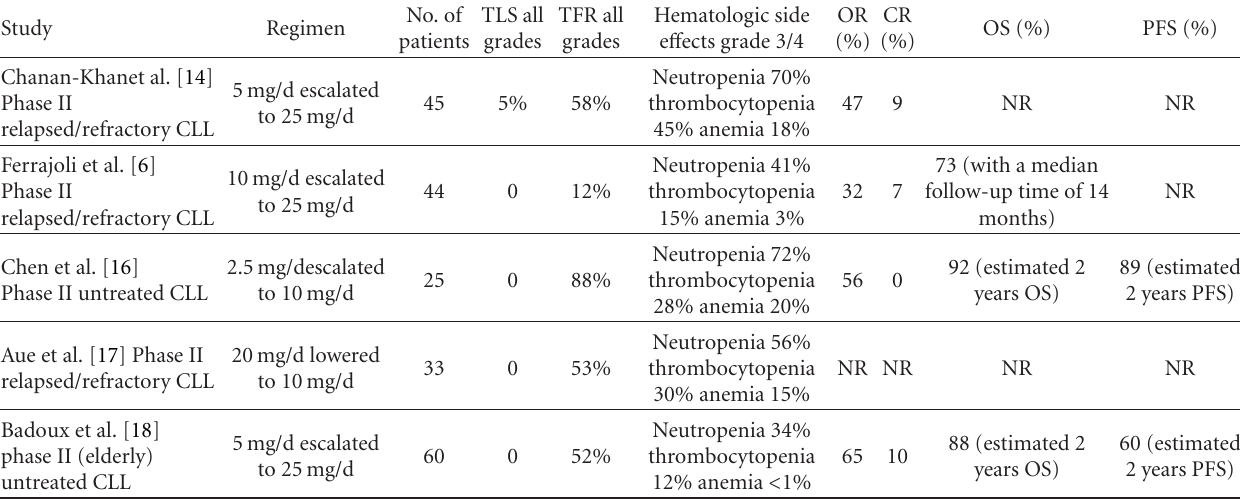
Table 1: Selected clinical trials using lenalidomide alone for treatment of CLL. NR: not